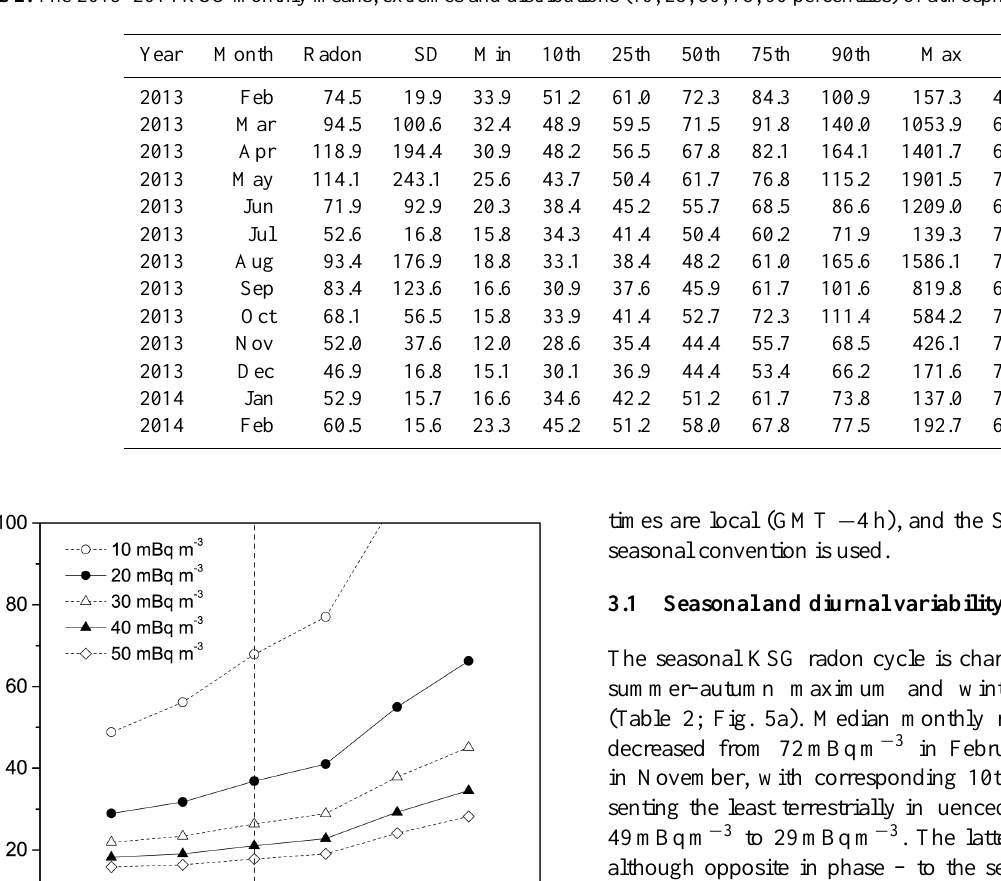
Table 2. The 2013–2014 KSG monthly means, extremes and distributions (10, 25, 50, 75, 90 percentiles) of atmospheric radon (mBqm − 3 ).